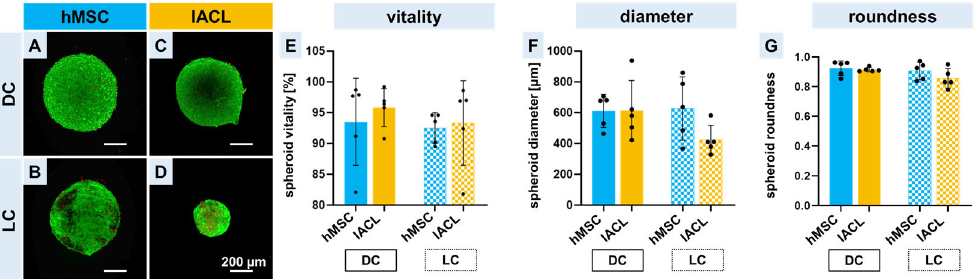
Figure 2. Vitality assay and shapes of spheroids prepared for scaffold seeding. Viable (green) and dead (red) human mesenchymal stem cells (hMSCs; A , B ) or lapine anterior cruciate ligamentocytes (lACLs; C , D ) of the spheroids two days after assembly before being seeded on the scaffolds. Direct cultivation (DC, directly after 2 days of spheroid formation) ( A , C ) and long pre ‐ cultivation (LC, 2 days of spheroid formation plus 14 days of cultivation) ( B , D ). Relative vitality ( E ), the diameter ( F ) and the roundness ( G ) of the spheroids before putting them on the scaffolds. Five independent experiments analyzed with ROUT (1%) outlier test and one ‐ way ANOVA showed no significant differences. Scale bars of 200 μ m.